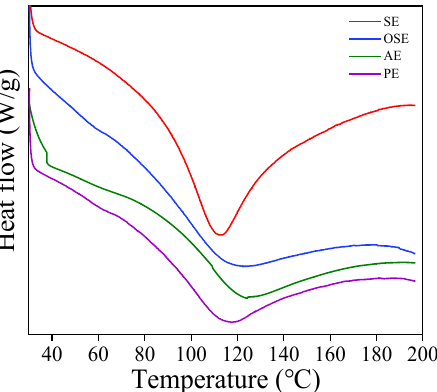
Figure 5. DSC thermogram of field muskmelon seeds protein extracted by different oil extraction methods.